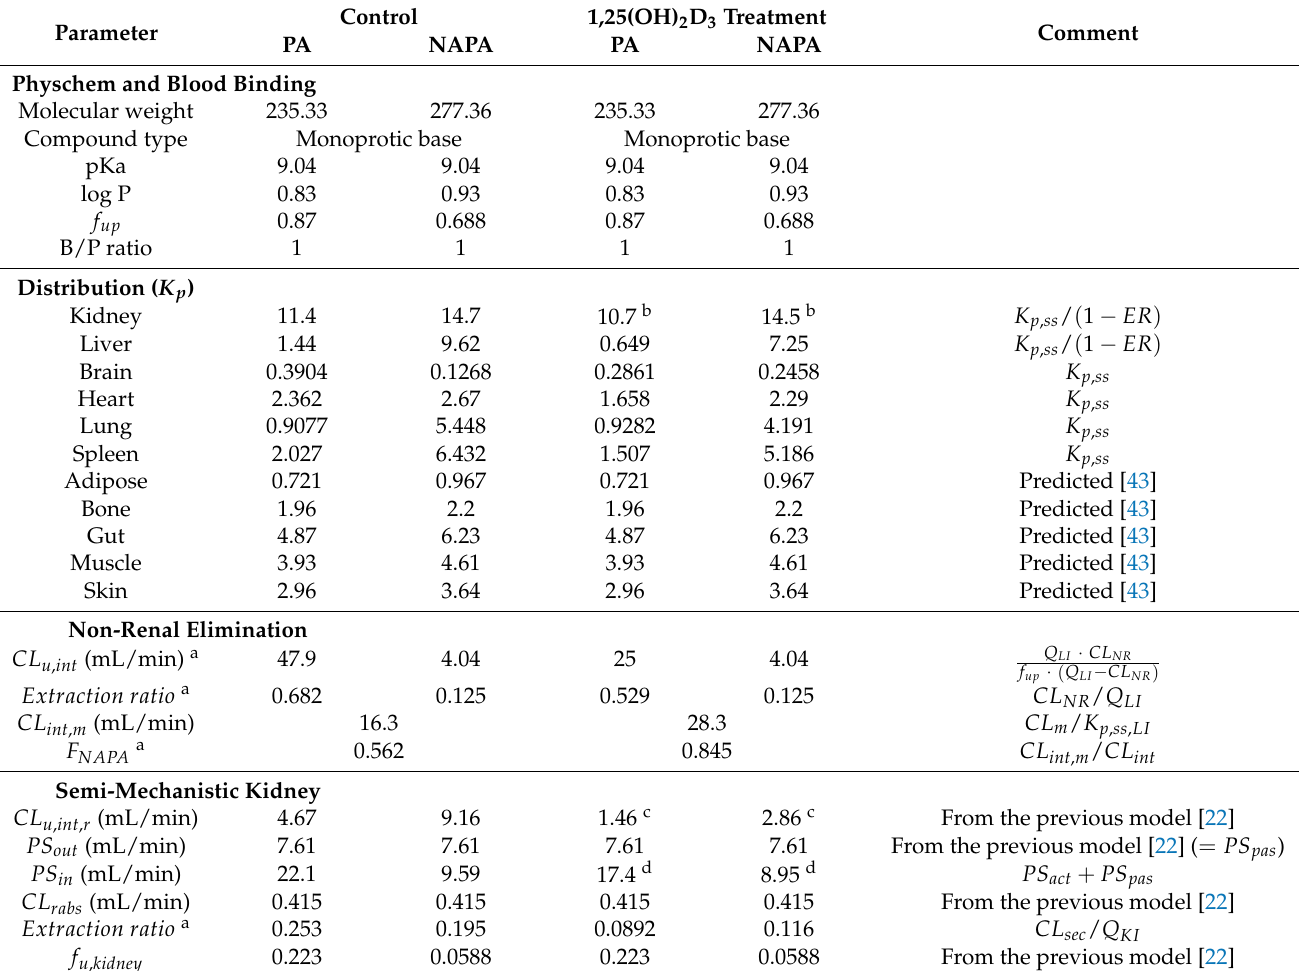
Table 3. Input parameters for PBPK modeling of PA and NAPA in the absence or presence of 1,25(OH) 2 D 3 treatment.